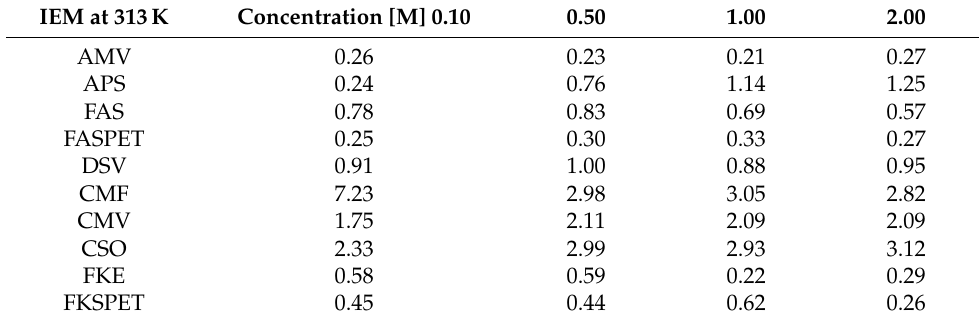
Table A6. Mean IEM conductivities [Sm − 1 ] at 313